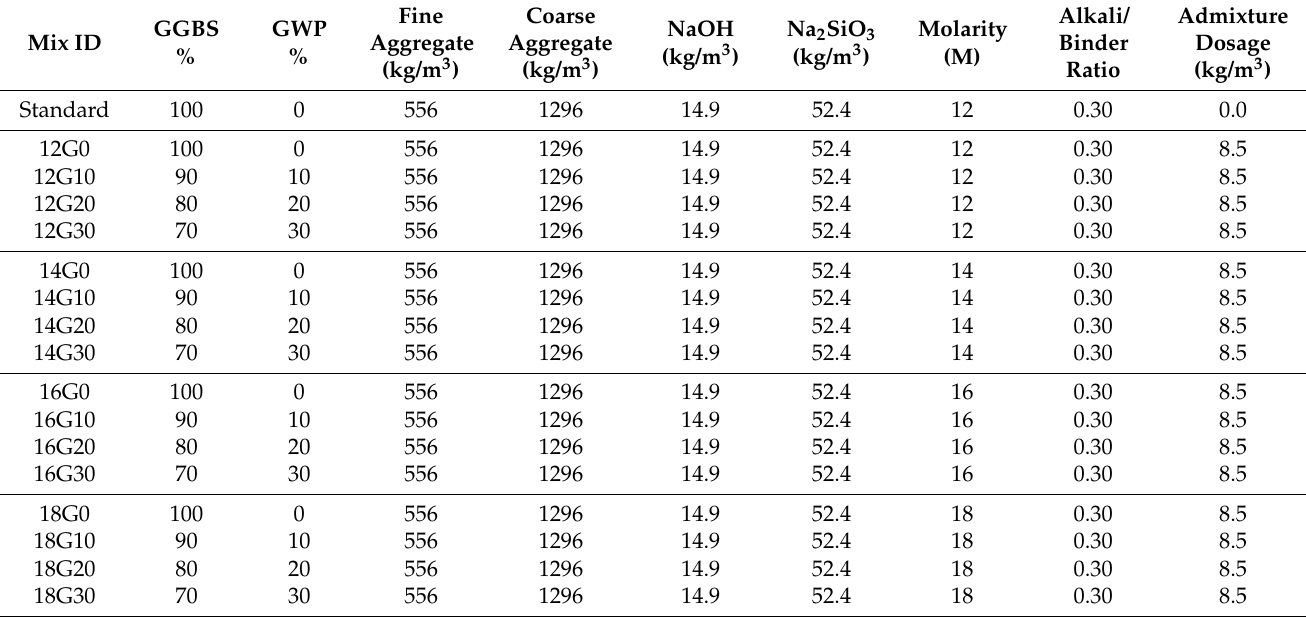
Table 2. Mix proportion considered for